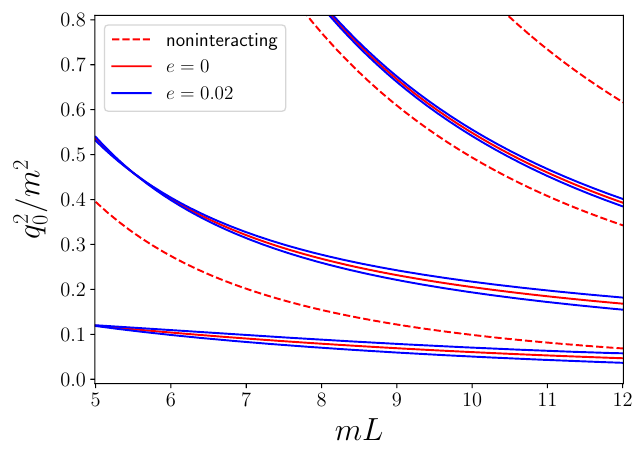
Figure 10 . The L -dependence of the energy levels for e = 0 , as well as for e 6 = 0 . For comparison, we plot the non-interacting energy levels as well, corresponding to the two free particles in a box. A single energy level at e = 0 splits into two nearby levels, when the external field is turned